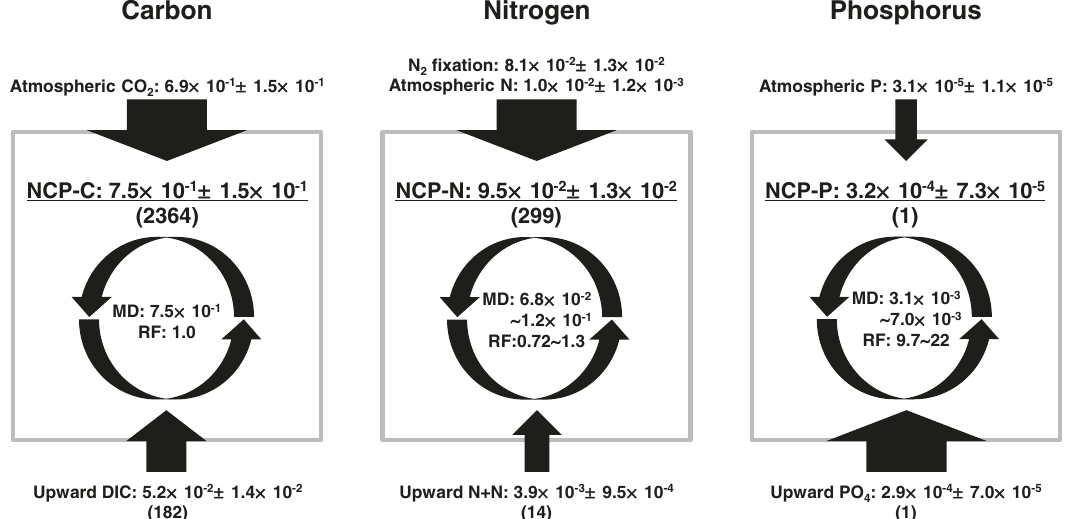
Fig. 4 The C, N, and P requirements for annual net community production (NCP). Each box represents the water column (0~100 m depth). The upward and downward black arrows with black text indicate the in fl uxes (mol m − 2 y − 1 ) from the subsurface layer (100~200-m depth) and atmosphere (including marine N 2 fi xation), respectively. The width of the arrows indicates the relative magnitudes of in fl uxes to the total in fl ux for each element. The C, N, and P requirements for annual NCP (mol m − 2 y − 1 ) are denoted using underlined text. Stoichiometric ratios of the NCP-C:NCP-N:NCP-P and upward dissolved inorganic carbon (DIC):nitrate plus nitrite (N + N):phosphate (PO 4 ) are denoted in parentheses. The microbial demands based on the C:N:P ratio of subtropical microbes 9,10 (MD, mol m − 2 y − 1 ) and the recycling factors (RF = MD/NCP, no unit) are represented within the circle of arrows. The errors